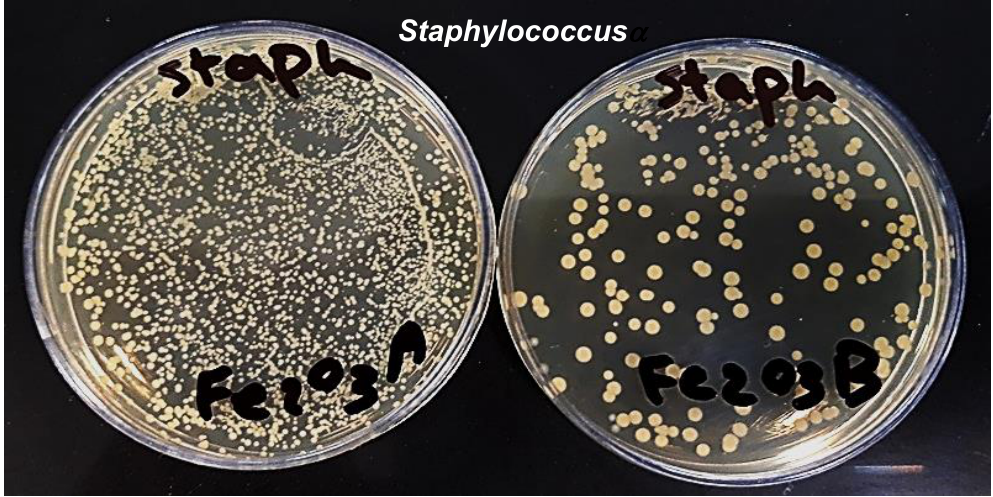
Figure 7. Antibacterial Activity on Staphylococcus Bacterium in (a) α-Fe 2 O 3 prior to Plasma Injection and (b)  -Fe 2 O 3 -P following Plasma